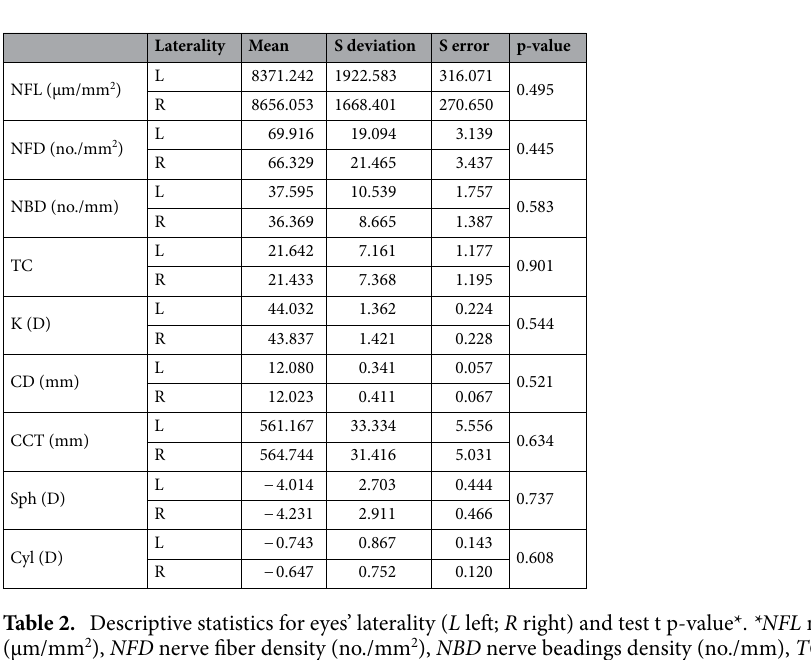
Figure 2. Distribution of the myopic refractive error in the examined eyes.